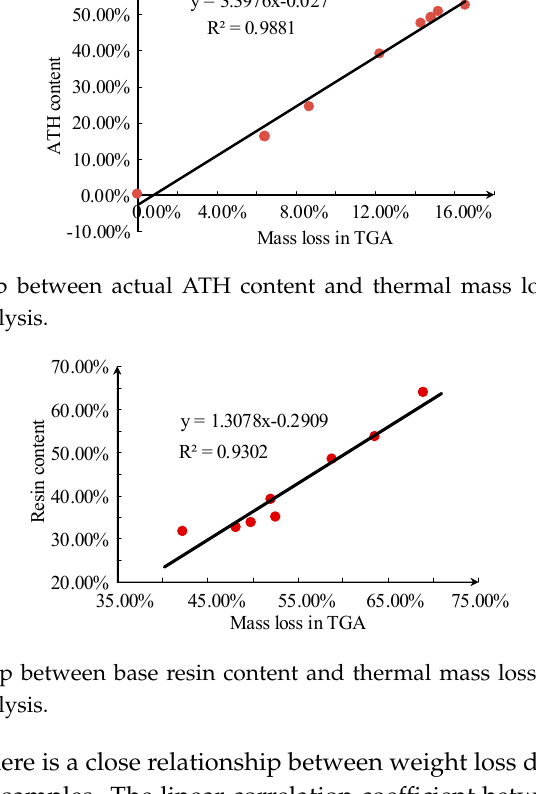
Figure 10. Relationship between base resin content and thermal mass loss in the second stage of thermogravimetric analysis.